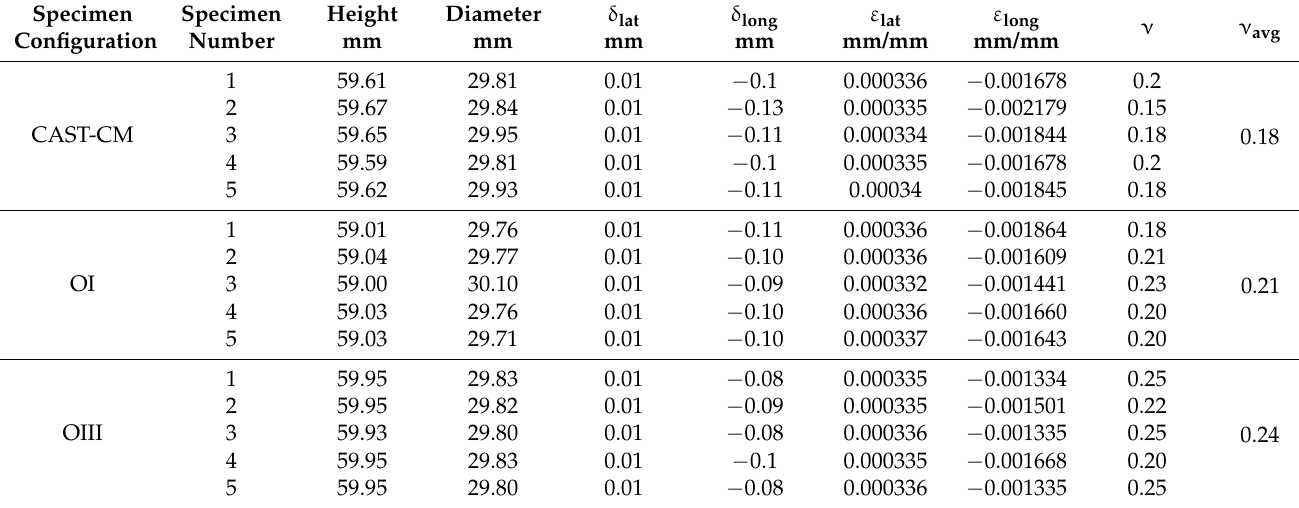
Table 3. Poisson ratios of CAST-CM, OI and OIII, taken as the average of 5 specimens per configuration.